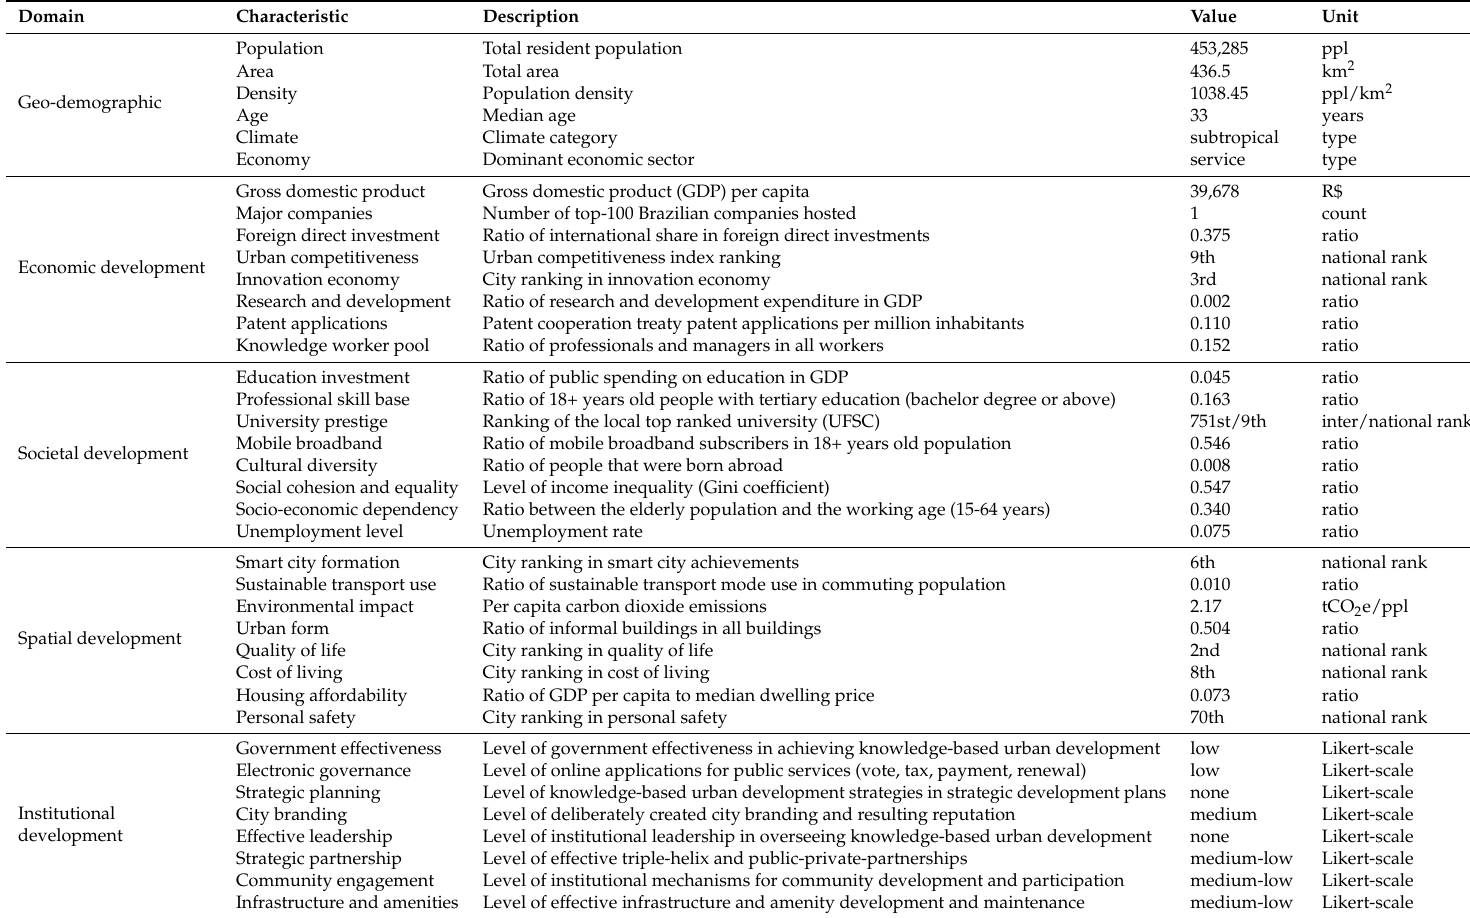
Table A1. Salient characteristics of Florianopolis, collected from various data